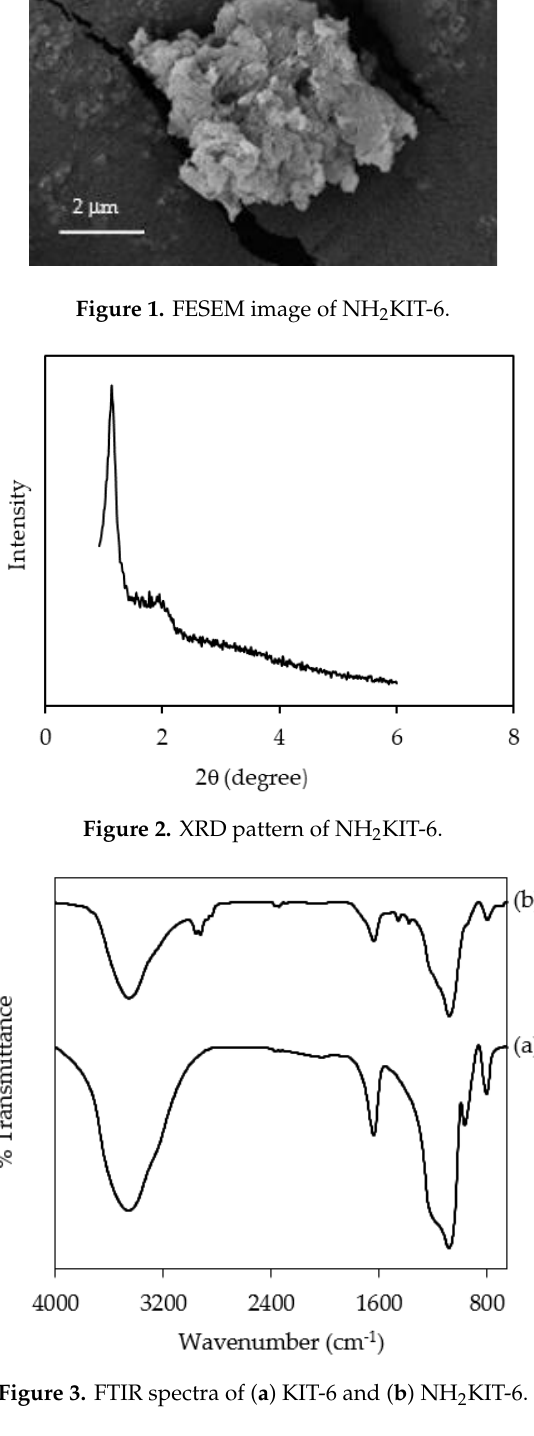
Figure 3. FTIR spectra of ( a ) KIT-6 and ( b ) NH 2 KIT-6.